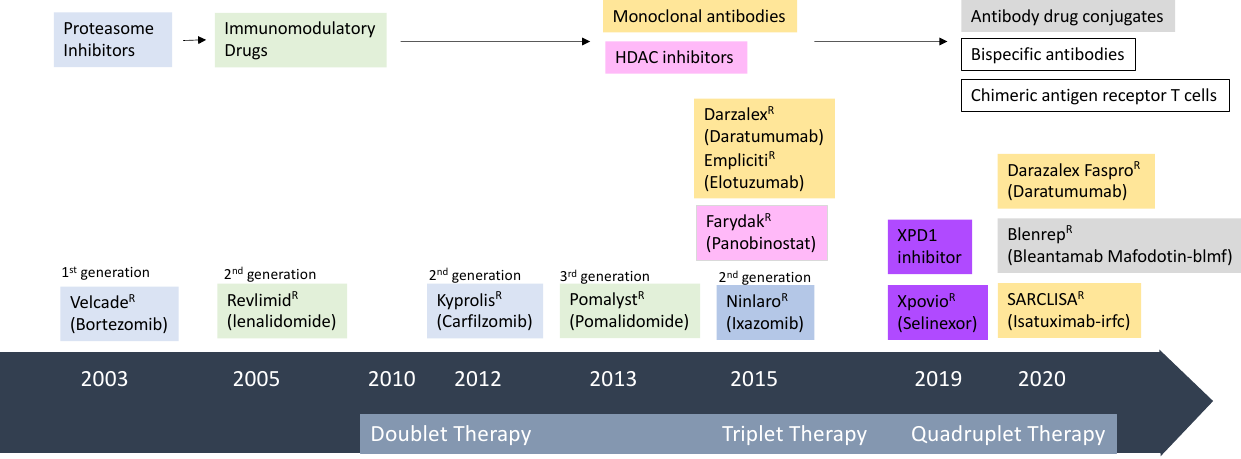
Figure 1. Timeline of world-wide drug development and approval in the treatment of multiple myeloma (MM). Table 1. Mechanisms of action in anti-CD38 monoclonal antibodies.